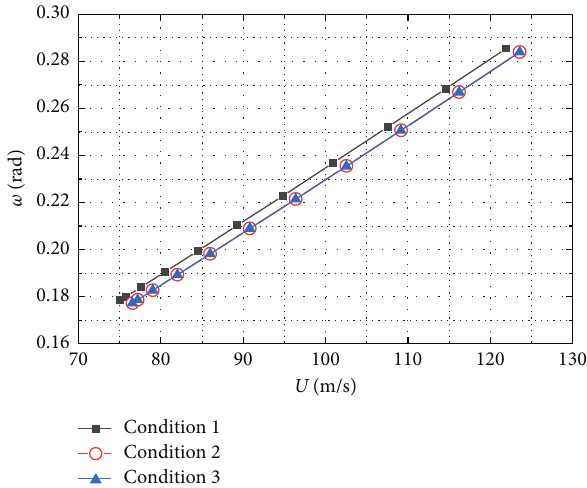
Figure 13: Curves of wind speed and frequency of LCOs in three conditions.